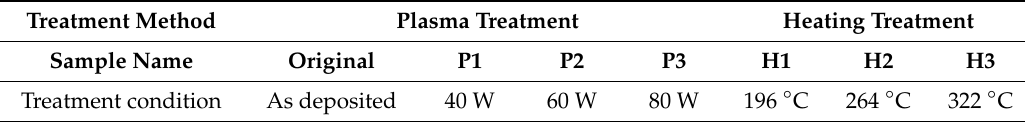
Table 3. The sample name and the treatment